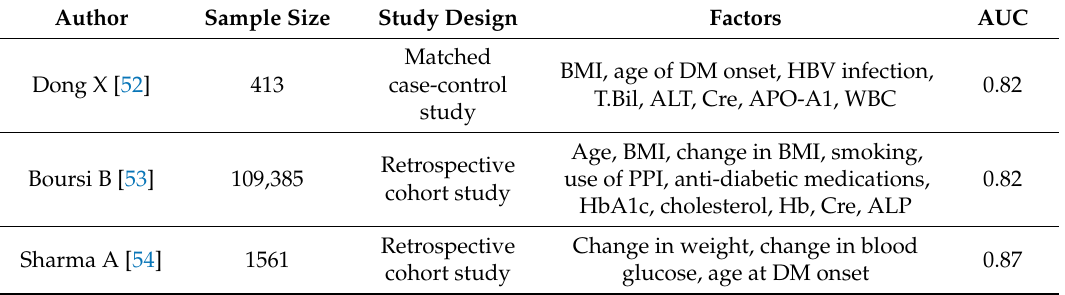
Table 2. Discrimination models for pancreatic cancer in patients with new-onset diabetes